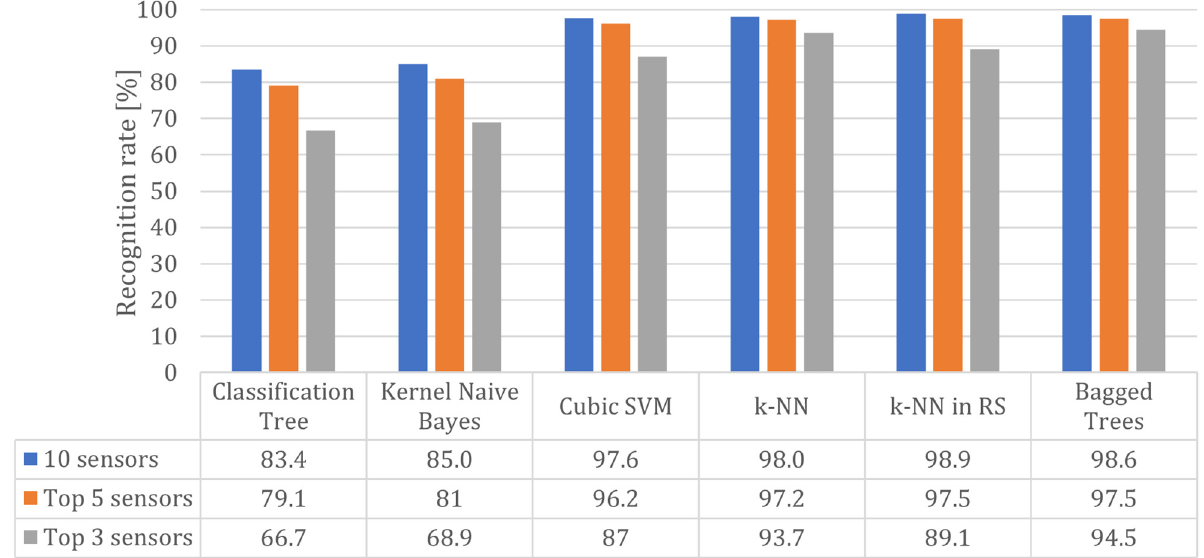
Figure 8. Classification efficiency as a function of the number of sensors used.